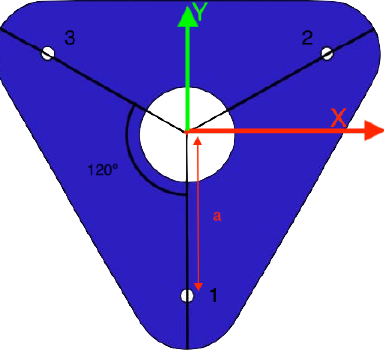
Figure 3. Description of tendon distribution in the soft